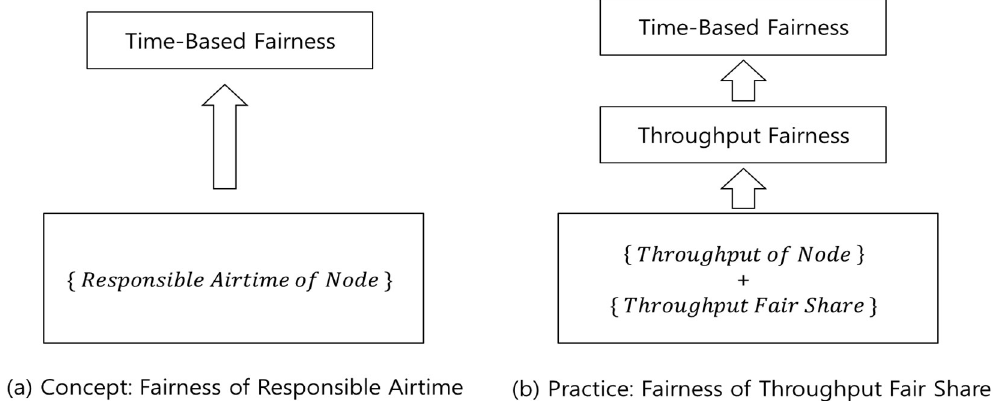
Figure 2. Responsible Airtime Fairness: Concept and Practice.